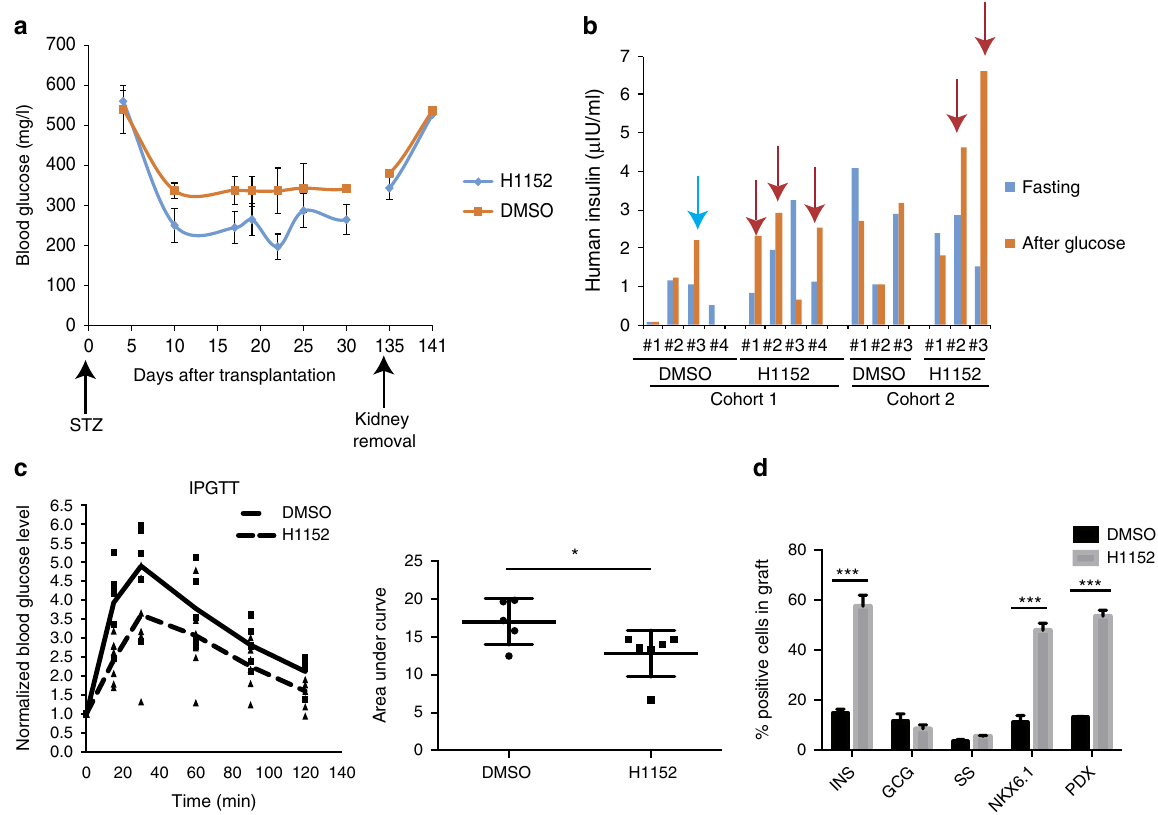
Fig. 5 H1152-treated cells show improved capacity to respond to glucose stimulation and maintain glucose homeostasis in vivo. a Blood glucose of mice transplanted with H1152-treated or DMSO-treated cells. The cells were transplanted at day − 4. 180mg/kg STZ was given at day 0. The kidneys were removed at day 134. Error bar is SEM. b GSIS of mice 5 weeks after transplantation with H1152-treated or DMSO-treated cells. The mice were fasted overnight and injected with 3 g/kg D-glucose. Red and blue arrows indicate positive GSIS in mice transplanted with H1152- or DMSO-treated cells, respectively. c IPGTT of mice 5 weeks after transplanted with H1152-treated or DMSO-treated cells. The mice were fasted overnight and injected